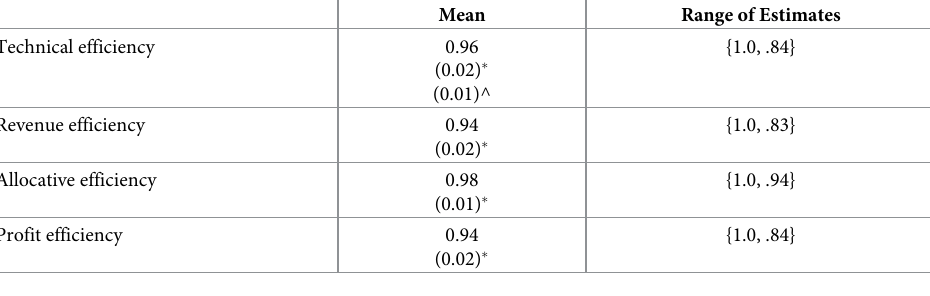
Table 3. Summary bull efficiency estimates from free disposal hull analysis (fat, protein and somatic cell count as outputs, semen as sole